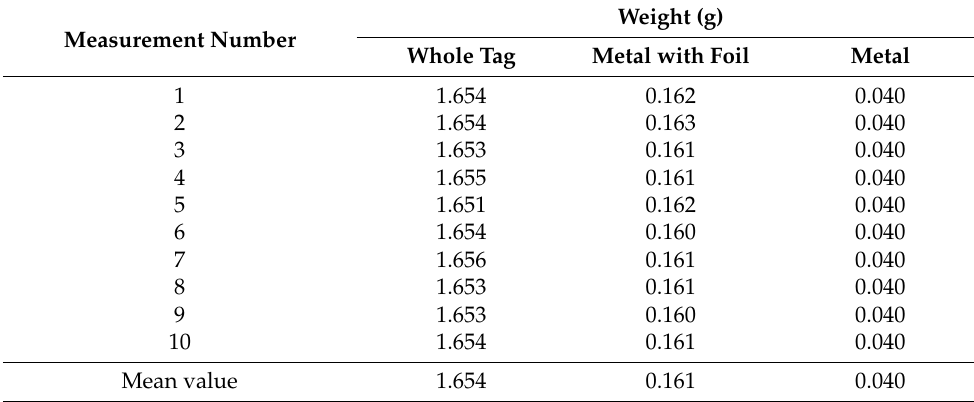
Table 2. The results of weight measurement of the investigated RFID identifier.